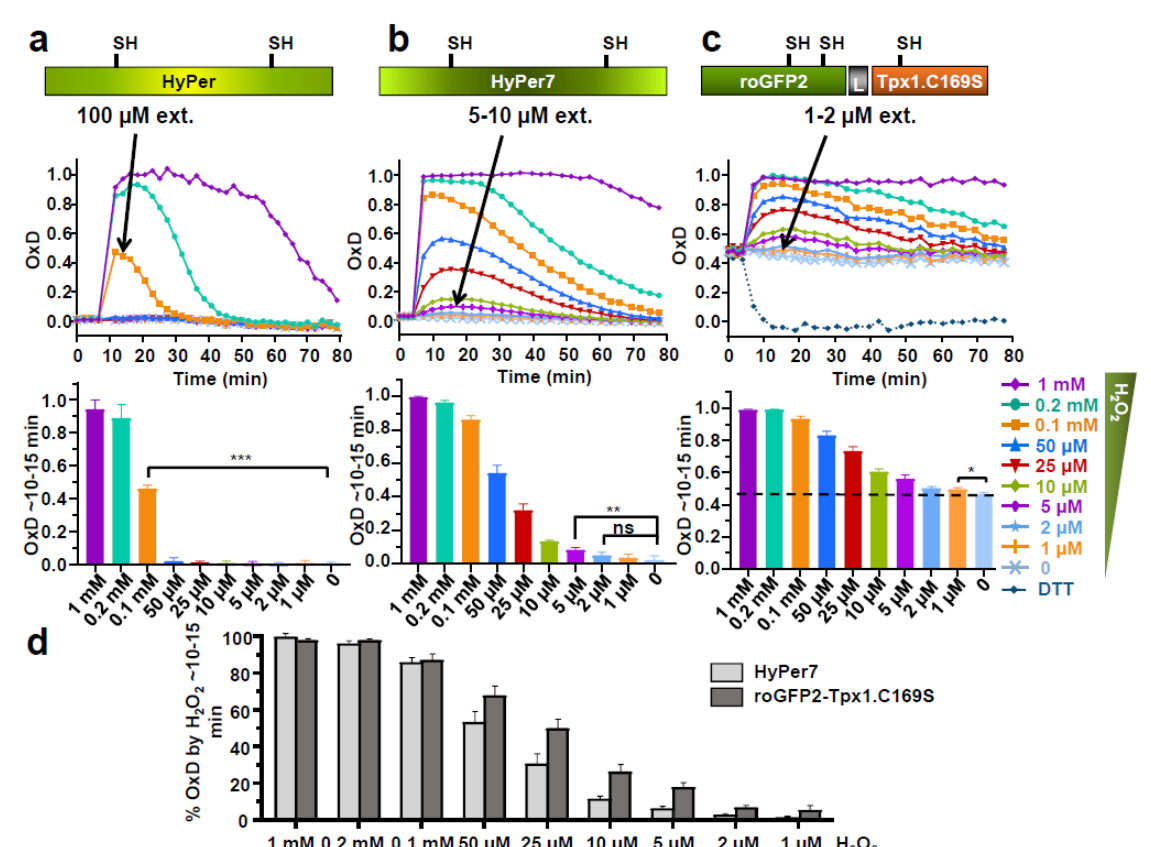
Figure 1. Expression of HyPer ( a ), HyPer7 ( b ) and roGFP2-Tpx1.C169S ( c ) in fission yeast. Wild-type strain HM123. was transformed with plasmids p605, p728, and p407.C169S to express HyPer, HyPer7, and roGFP2-Tpx1.C169S, respectively. The indicated extracellular concentrations of H 2 O 2 were directly added to MM cultures at an OD 600 of 1 in 96-well imaging plates, and growth proceeded at 30 °C for the time indicated with shaking. The degree of probe oxidation (amount of probe oxidized per 1) is indicated in the Y-axis (OxD). The minimum concentrations of H 2 O 2 capable of causing probe oxidation are indicated with arrows. For each strain, average data from three biological replicates are shown, with error bars (S.D.) displayed in Figure S1. Graph bars (bottom panels of a – c ) represent the average OxD between 10 and 15 min for each treatment. Statistical significance was calculated between the indicated samples with an unpaired Student’s t -test with P-values of 0.05 (*), 0.01 (**), and 0.001 (***); ns, non-significant. ( d ) Percentage of oxidation of HyPer7 and roGFP2-Tpx1.C169S upon H 2 O 2 treatments. Data from panels b and c are represented as the average of the percentage of oxidation between 10 and 15 min for each treatment, as described in Materials and Methods.